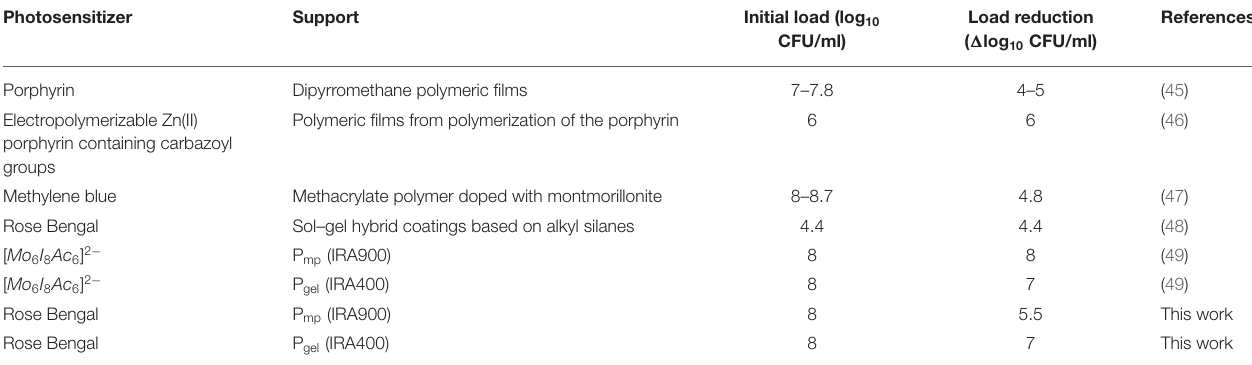
TABLE 2 | Recent examples reported in the literature of Staphylococcus aureus inactivation caused by photosensitizing materials.